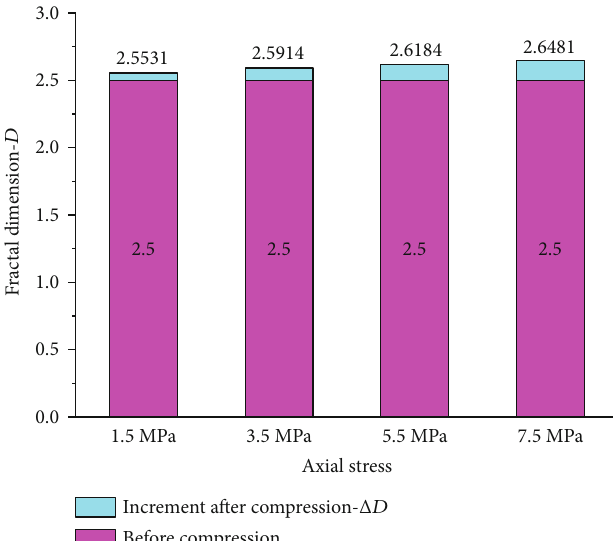
Figure 8: Change in fractal dimensions of crushed sandstone samples of di ff erent axial stresses before and after compression (axial stress of 3.5MPa).